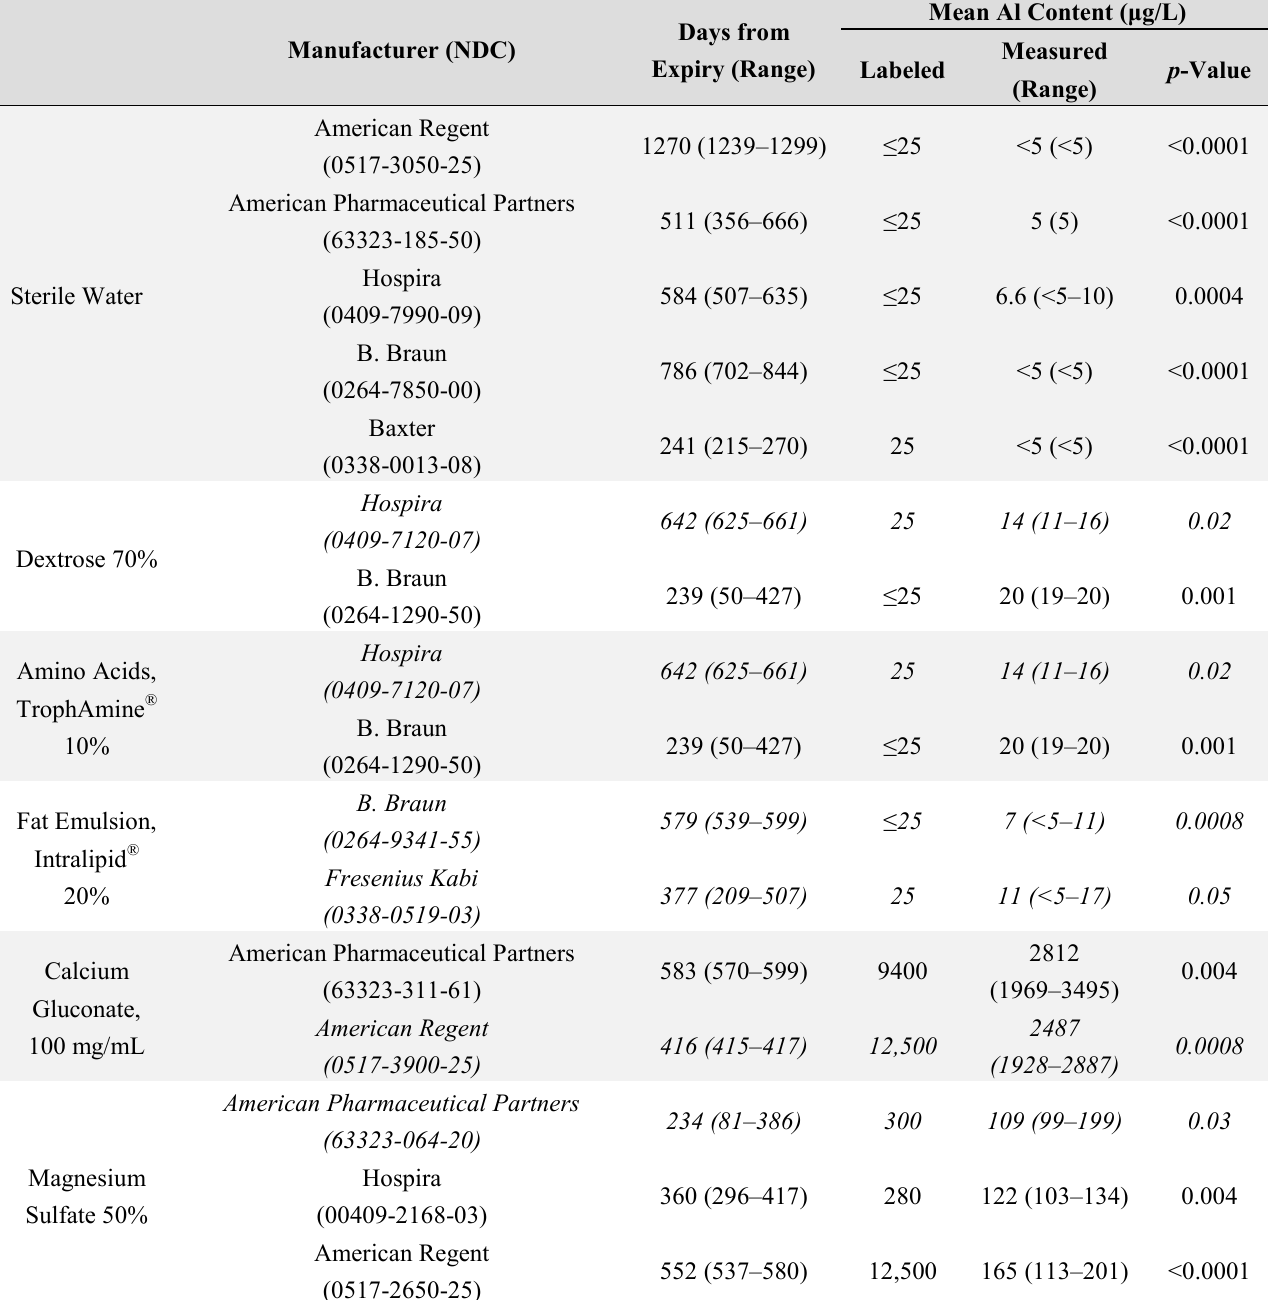
Table 1. Aluminum content of various products used in parenteral nutrition solutions. Reprinted with the permission from